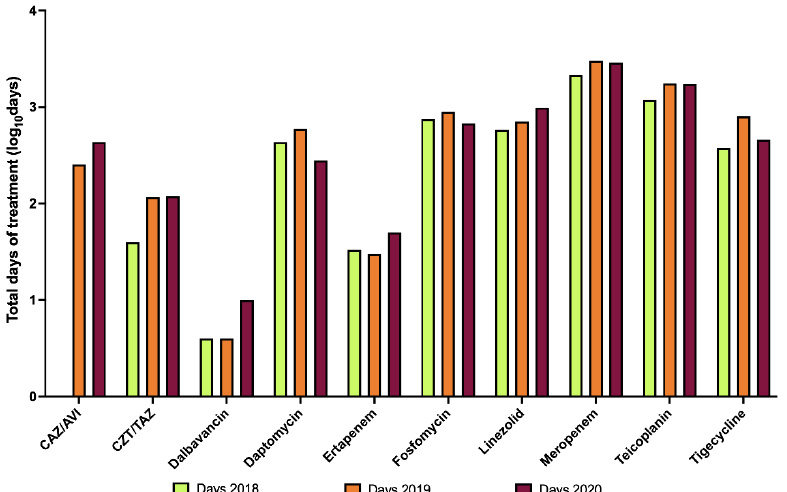
Figure 4. Total use of antibiotics belonging to a restricted list in COVID-19 wards, during the first year of the pandemic (Days 2020) compared with total use within the same wards during the two pre-pandemic years (days 2018, days 2019). Y axis is in logarithmic scale. It can be noticed that in 2020 the use of each antibiotic was constant or even lower than the years before, despite an